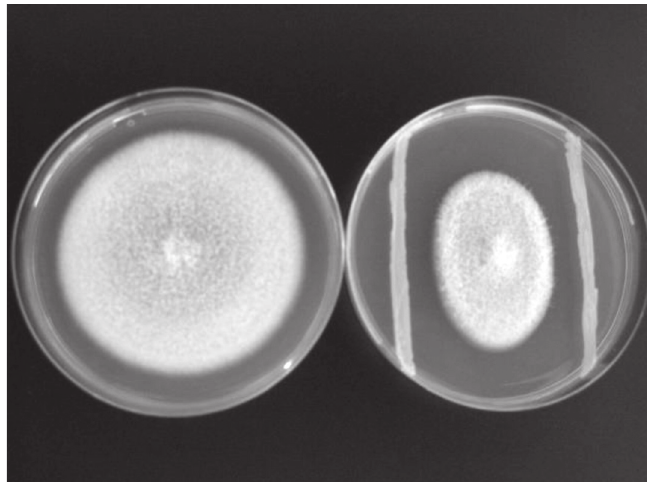
Figure 2. Inhibition of the in vitro growth of the Phoma medicaginis Pm 4 by Sinorhizobium meliloti strain 10.16/R6 on PDA medium. A, control mycelial growth; B, mycelial growth where S. meliloti was co-inoculated.